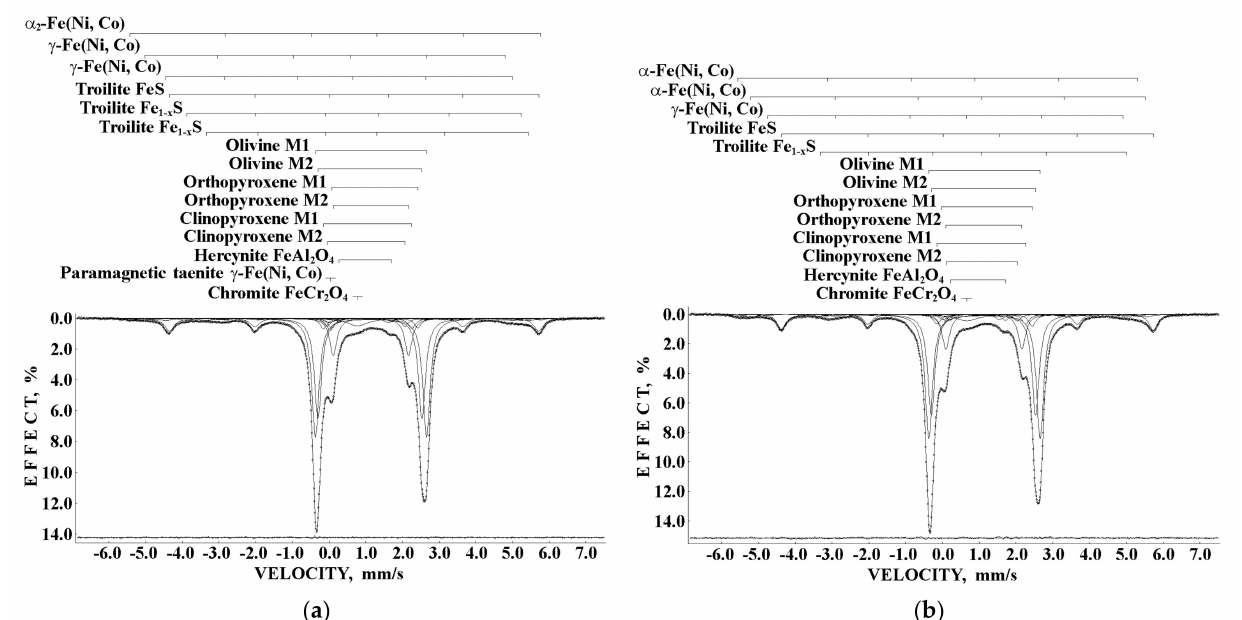
Figure 35. Room temperature Mössbauer spectra of equilibrated ordinary chondrites NWA 6286 LL6 ( a ) and NWA 7857 LL6 ( b ). Indicated components are the results of the best fits. The differential spectra are shown on the bottom. Adapted from Reference